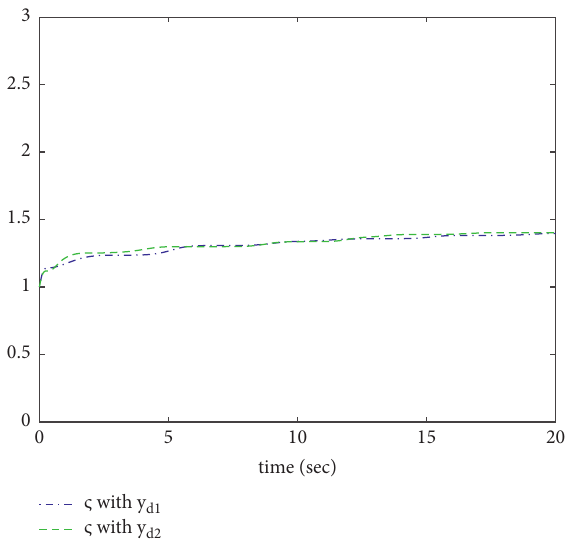
Figure 11: The Nussbaum variables ς with x